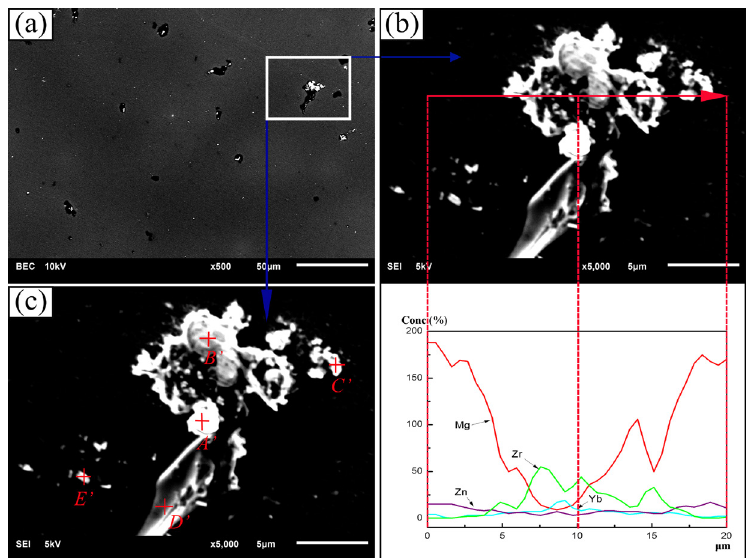
Figure 8. (a) SEM image of the phase constitution after homogenization (380 ºC × 12 h), (b) concentration profile of the composition across the coarse phase and (c) high magnification image of the selected area in (a), measured by